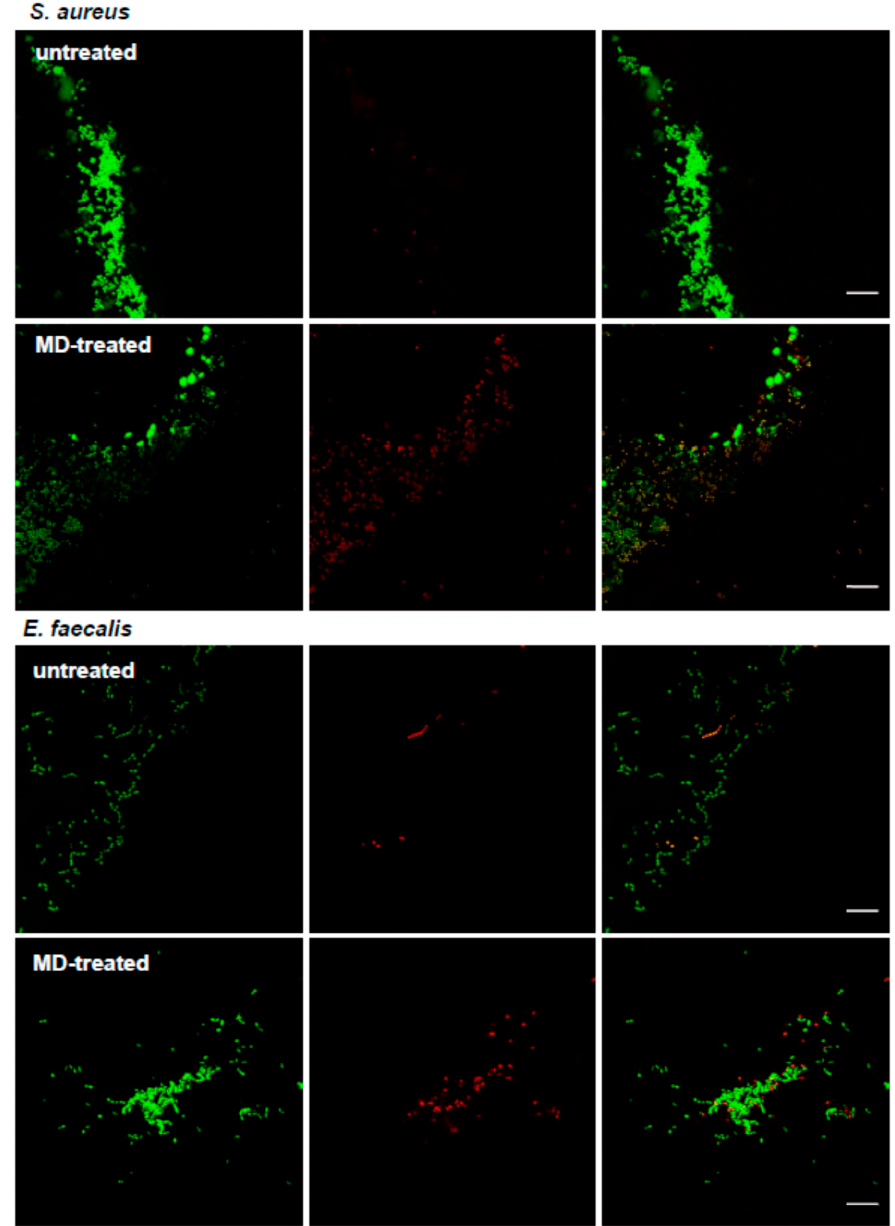
Figure 7. Representative images obtained by confocal laser scanning microscopy (CLSM) of S. aureus and E. faecalis grown on sutures untreated and MD-treated, stained with BacLight kit (bar: 10 µ m). Green fluorescence indicates live cells, and red fluorescence indicate dead cells. In the untreated samples, aggregates of live cells organized in a biofilm were visible. On the contrary, in the MD-treated sutures, an increased number of dead cells was